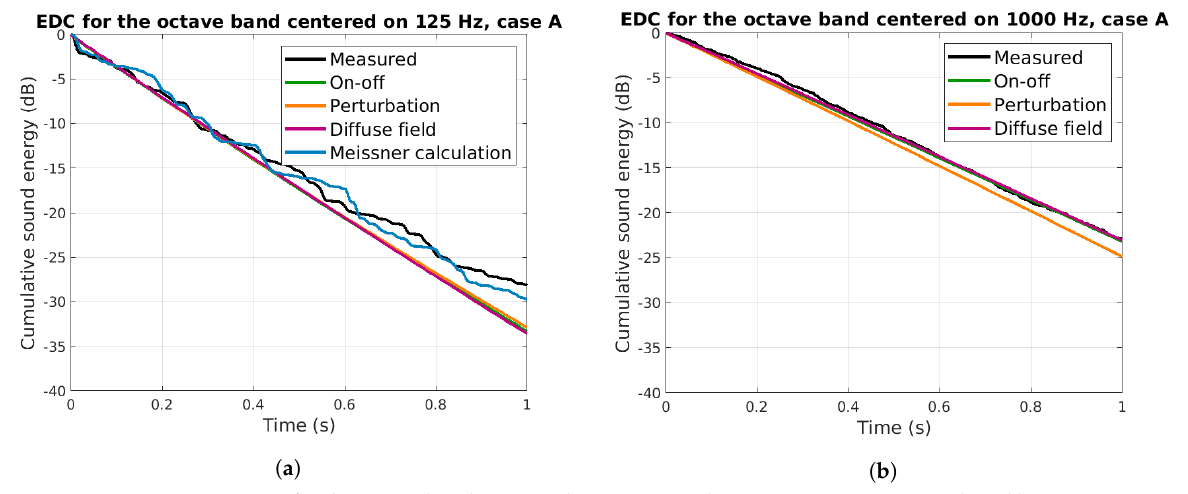
Figure 5. Energy Decay Curves for the octave bands centered on 125 Hz and 1000 Hz in case A, as produced by measurements and simulation, as well as (in the case of 125 Hz) Meissner’s algorithm. The results are for source position 1 and listener position 1 in Figure 2. In ( a ), there are significant differences between measurements and Meissner’s calculations on one hand and simulations on the other. This may be indicative of influences from room modes. In ( b ), the differences between simulations and measurements are smaller. The measured decay curve in the higher-frequency case is much more